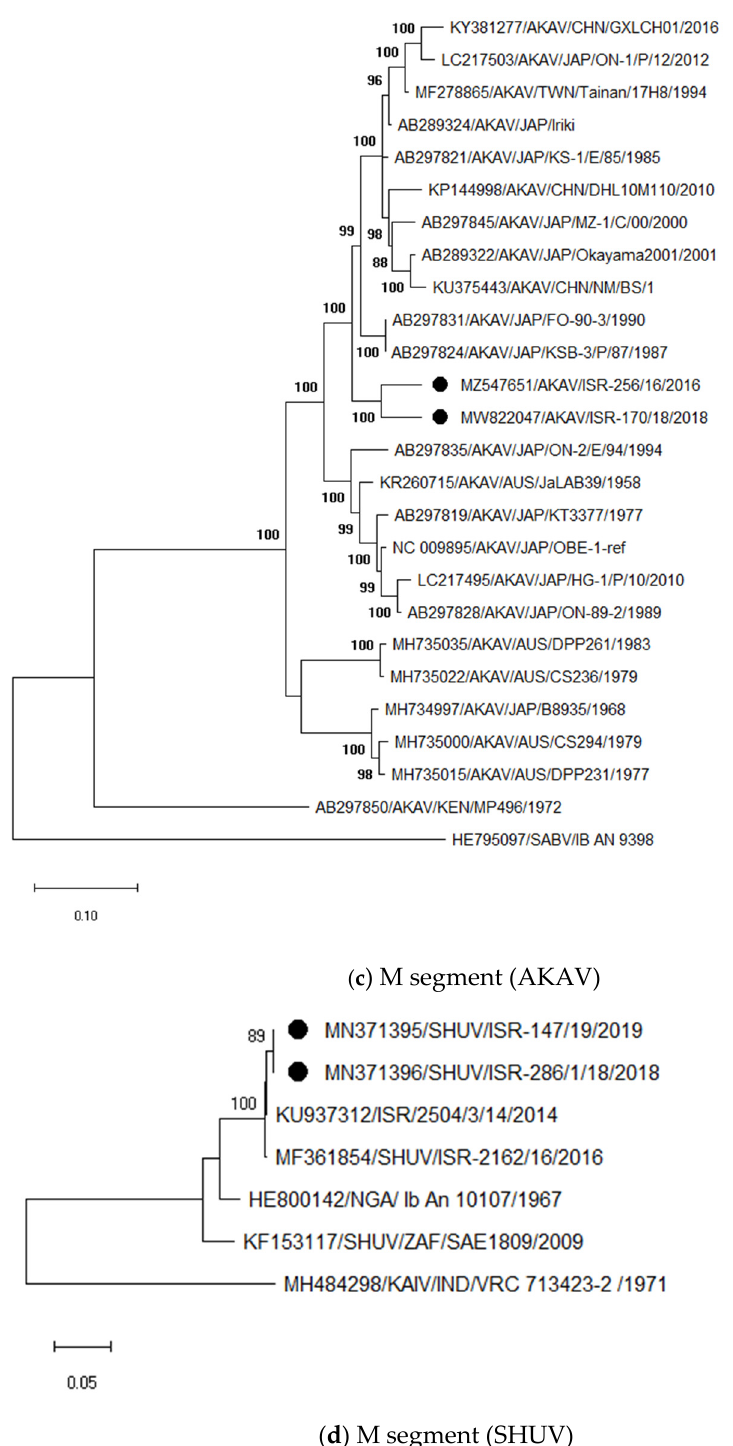
Figure 1. Phylogenetic analyses of the Akabane and Shuni viruses (AKAV and SHUV) based on nucleotide sequences of the L ( a ), S ( b ) and M segment ( c , d ). The sequences obtained from NCBI GenBank are labelled by accession number/virus/location/isolate/year (when all data is available in GenBank or the corresponding publications) and sequences generated in the present study are marked by black dots. Nucleotide sequences were analyzed using the Maximum Likelihood method and Tamura-Nei model. Statistical support for nodes was obtained by bootstrapping (1000 replicates); only values ≥ 70 % are shown. Scale bars indicate nucleotide substitutions per site.